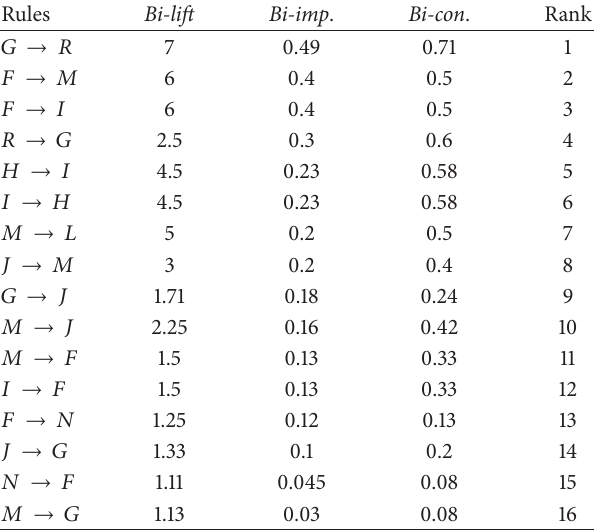
Table 6: The sort of positive association rules.